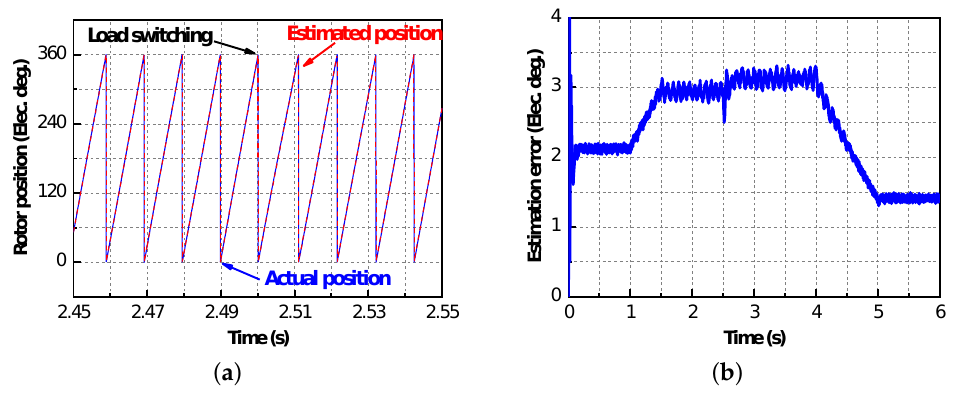
Figure 22. Simulation results of rotor position by extended EMF-based method. ( a ) Rotor position and ( b ) estimation error.